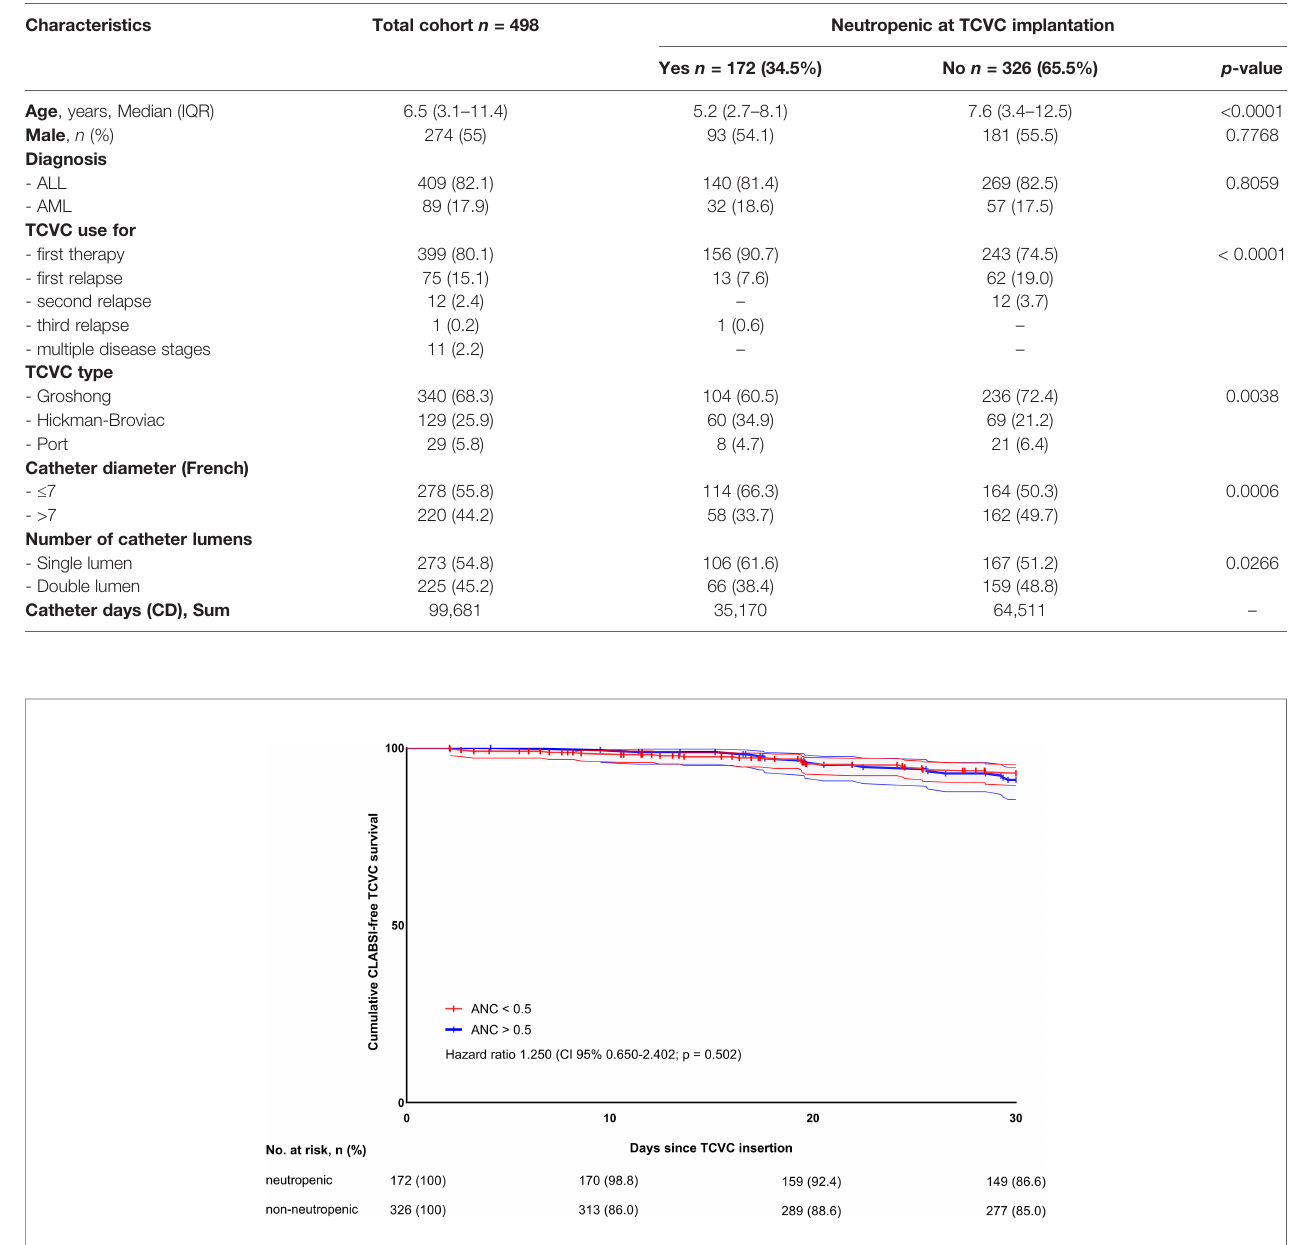
FIGURE 1 | Thirty-day CLABSI-free TCVC survival in neutropenic and non-neutropenic patients.